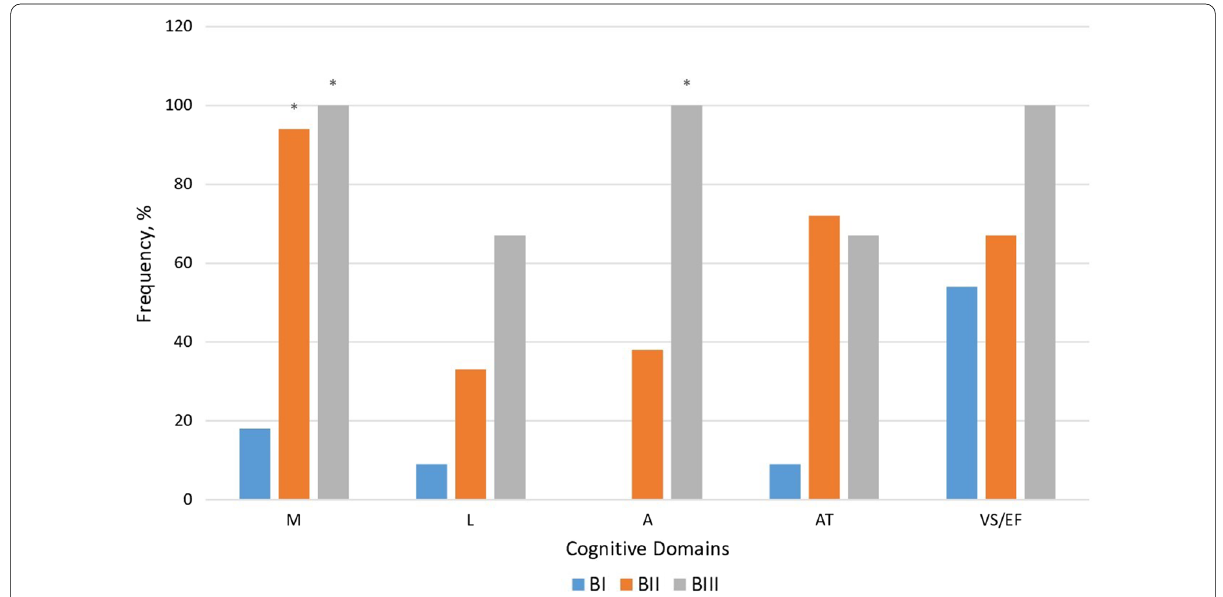
Fig. 3 Distribution of affected domains in the B group depending on age, level of CI and simultaneous lesions of FL and CC (* p <